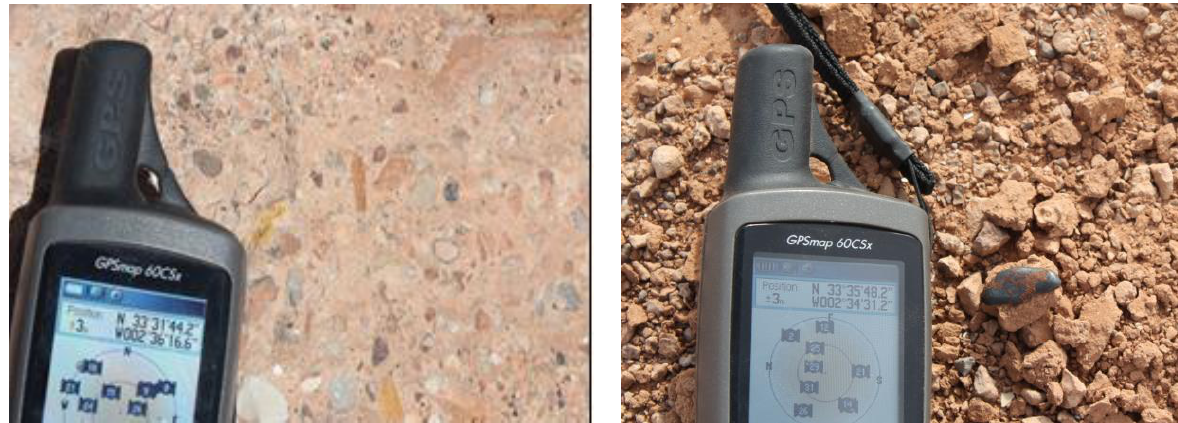
Figure 2. Conglomerates of the Oglat Sidi Ali site ( left ); a 30 g meteorite sample, buried at a depth of a few centimeters ( right ).